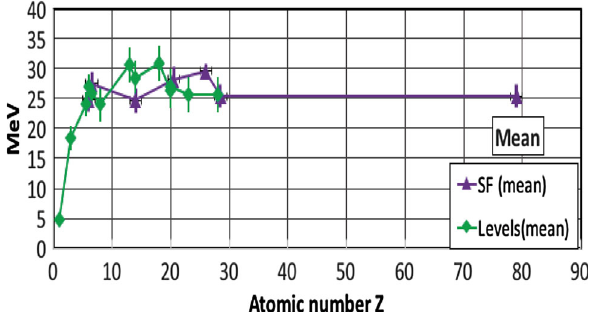
Fig. 6 Average removal energies versus atomic number Z. Values of (cid:5) (cid:2) P (cid:6) SF fromtestsoftheKoltunsumrulein ee (cid:2) p experiments(inpurple) are compared to values of (cid:5) (cid:2) P (cid:6) le v els extracted from ee (cid:2) p measurements of “level missing energies” (in green) where (cid:6) (cid:5) k 2 (cid:6) P , N + M 2 − M ≈ (cid:5) T P , N (cid:6) = A summary of the relationships between excitation energy , N genie (which incorporates the Bodek-Ritchie E P x used in [35] off-shell formalism), separation energy S P , N ,